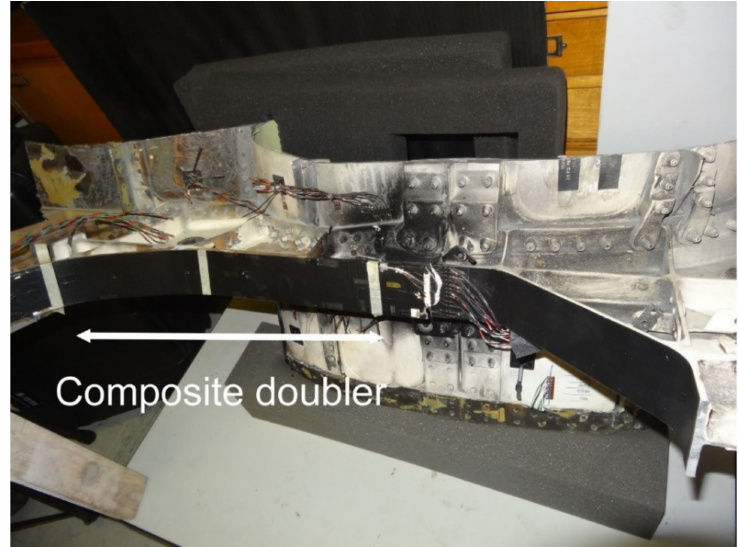
Figure A7. Overall view of a section of the Y488 bulkhead, with the doubler and surrounding section painted black prior to performing lock-in thermography